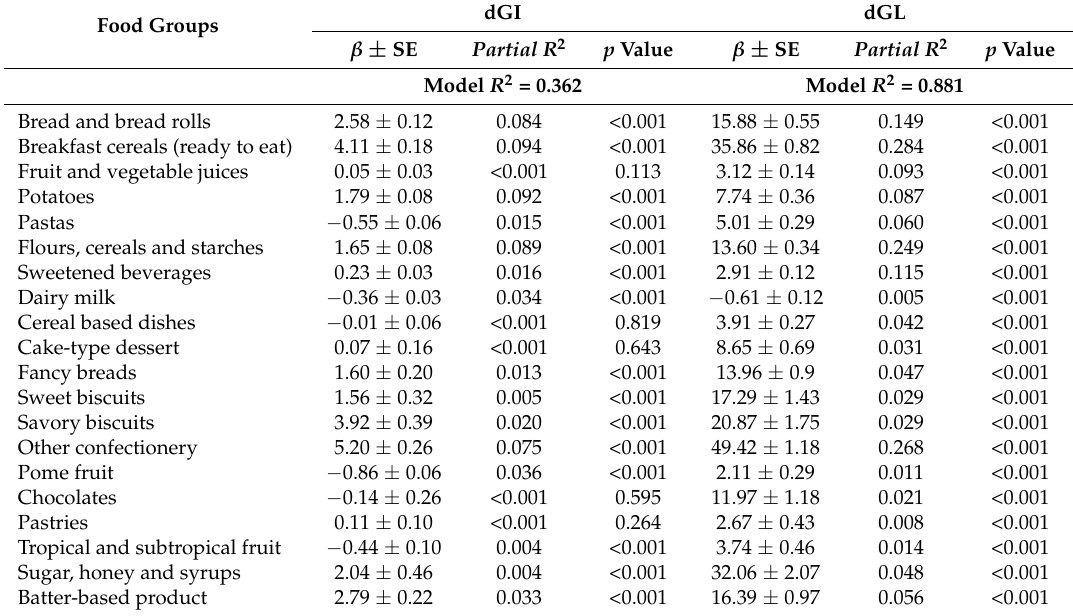
Table A5. The contribution of the top 20 GL food groups to inter-individual variations in dietary glycaemic index (dGI) and glycaemic load (dGL) in 2007NS ( n = 4828, all subjects